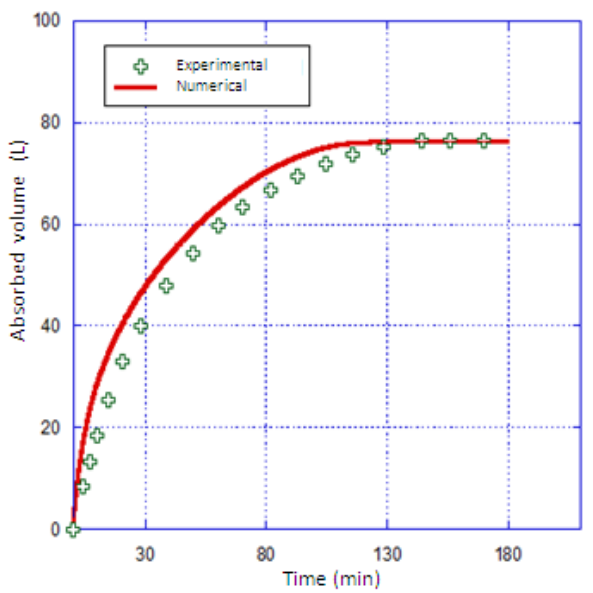
Figure 2. Validation of the model.